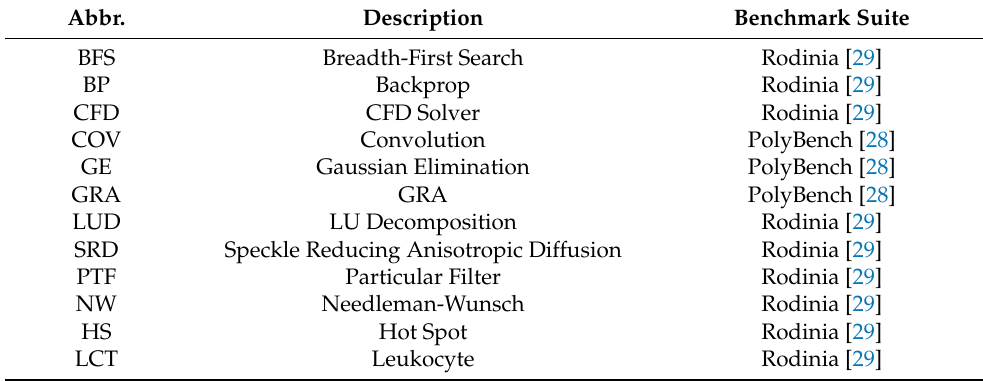
Table 3. Information of benchmarks.